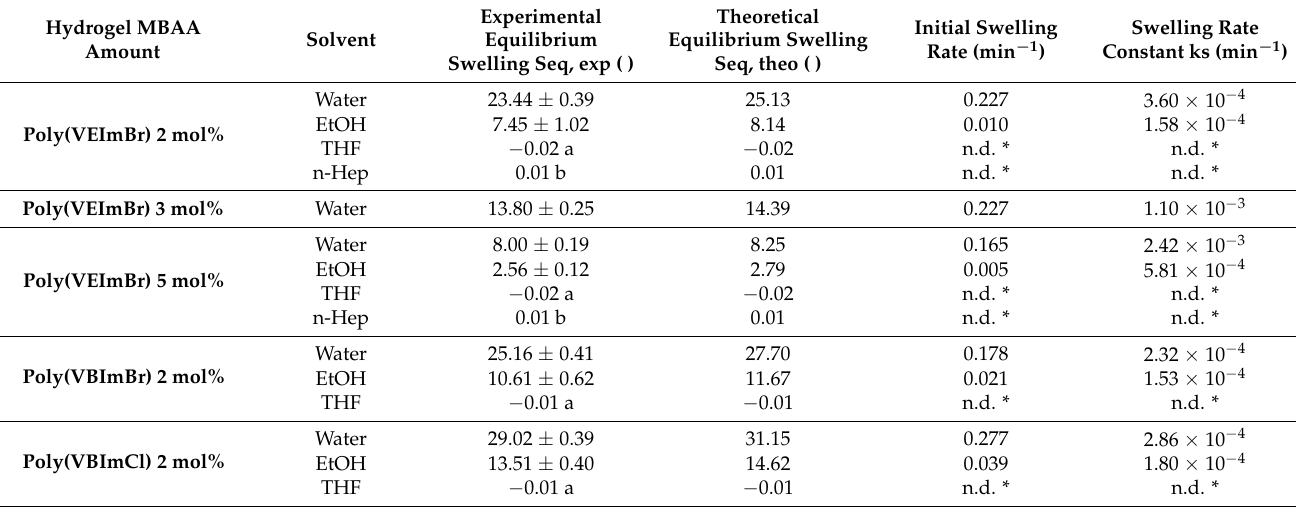
Table 2. Swelling kinetics studies of different hydrogels.